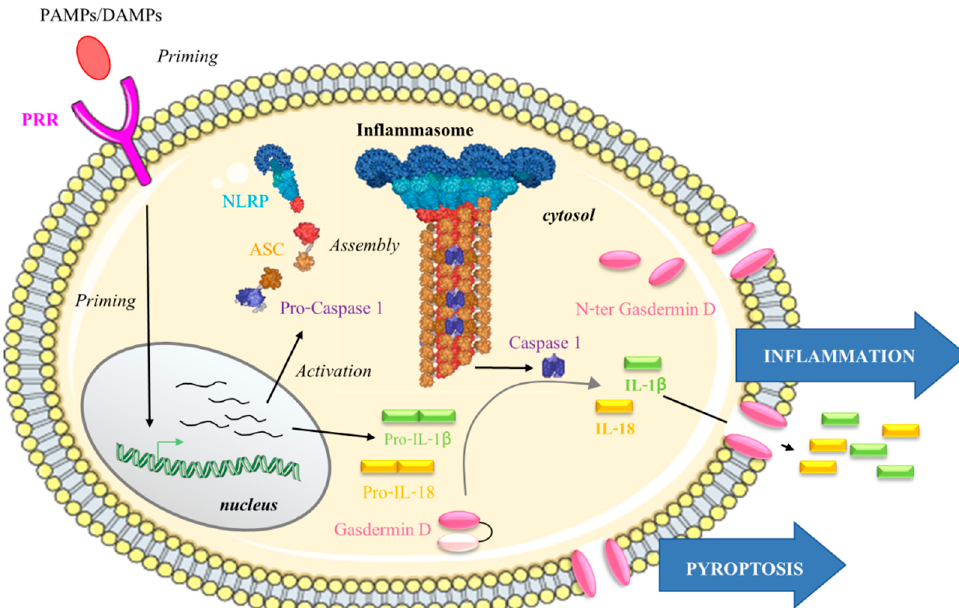
Figure 6. NLRP inflammasome activation. Following the priming step (transcriptional and/or not), the activated NLRP can form the inflammasome with ASC and pro-caspase 1. This functional NLRP inflammasome leads to the autolytic cleavage of pro-caspase 1 into caspase-1, which is the active enzyme. Downstream, caspase-1 activates the interleukins IL18 and IL1 β but also releases the N-terminal fragment of the gasdermin D from the inhibitory C-terminal fragment. Finally, a formation of pores by the N-terminal gasdermin D at the plasma membrane induces pyroptosis and propagation of the inflammatory signal [117,124,126].